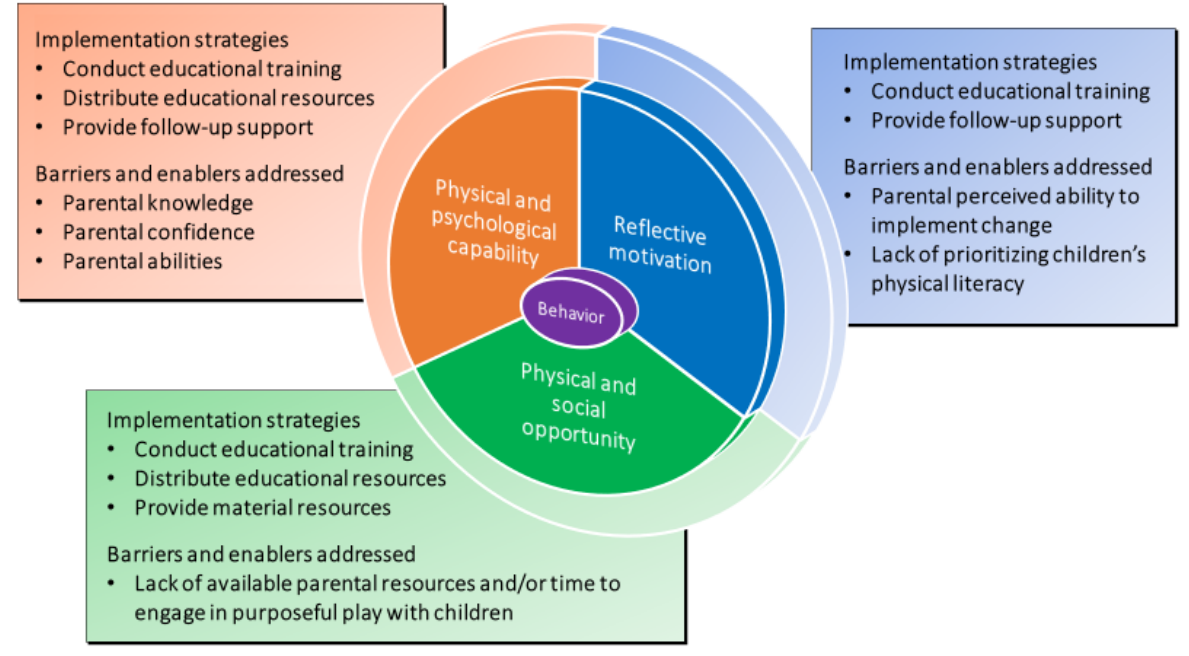
Figure 1. Implementation strategies of the virtual PLAYshop program and the barriers and enablers that were addressed and mapped to the COM-B model.